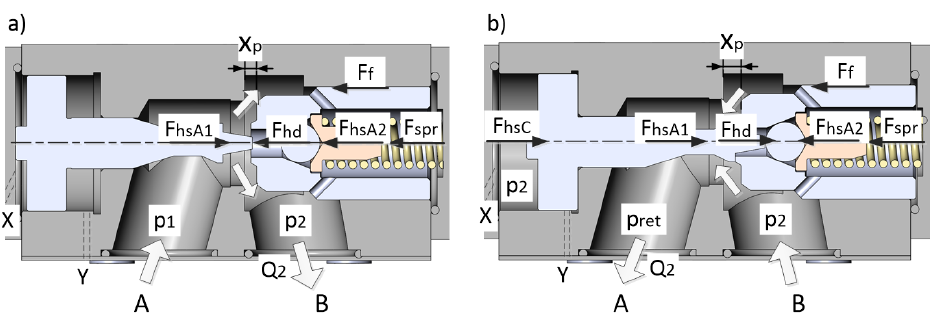
Figure 3. Balance of forces acting on the check valve poppet; ( a ) A-B flow direction, ( b ) B-A flow